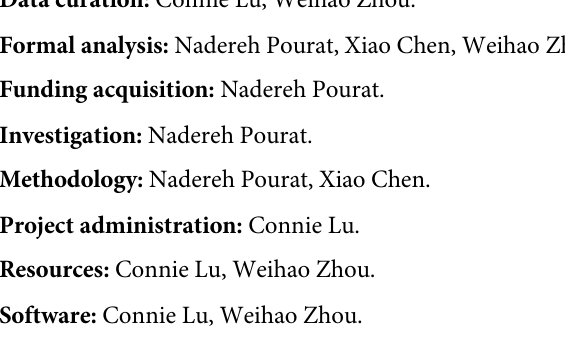
S1 Table. Performance measures and full clinical quality performance measure definition. S2 Table. Unadjusted and adjusted predicted probabilities of health center quality indica- tors by urban and rural status. S3 Table. Regression models of prevention quality performance indicators. S4 Table. Regression models of care management quality indicators. S5 Table. Regression models of outcome quality indicators. S6 Table. Logistic regression models of health centers that met prevention quality perfor- mance indicator benchmarks. S7 Table. Logistic regression models of health centers that met care management quality performance indicator benchmarks. S8 Table. Logistic regression models of health centers that met outcome quality perfor- mance indicator